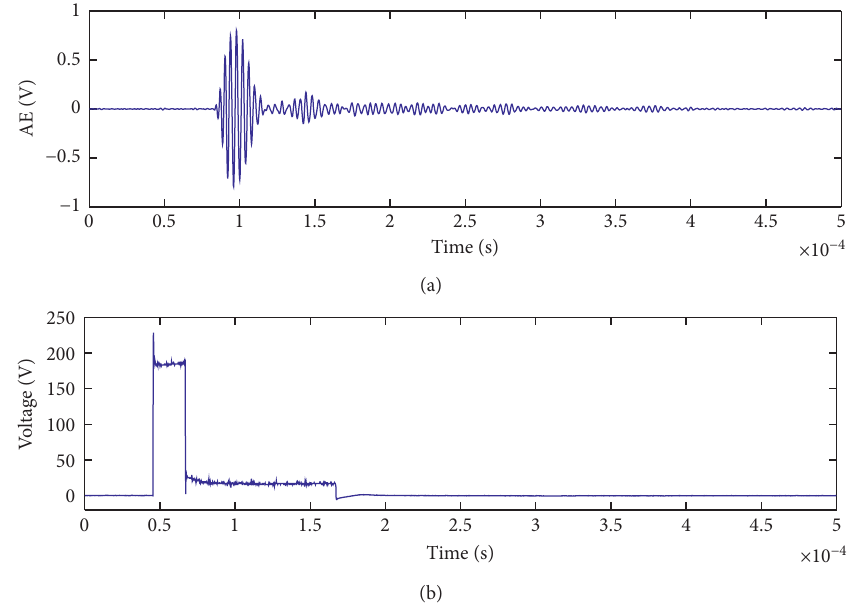
Figure 6: AE wave generated by discharge in kerosene: (a) AE signal and (b) discharge voltage.